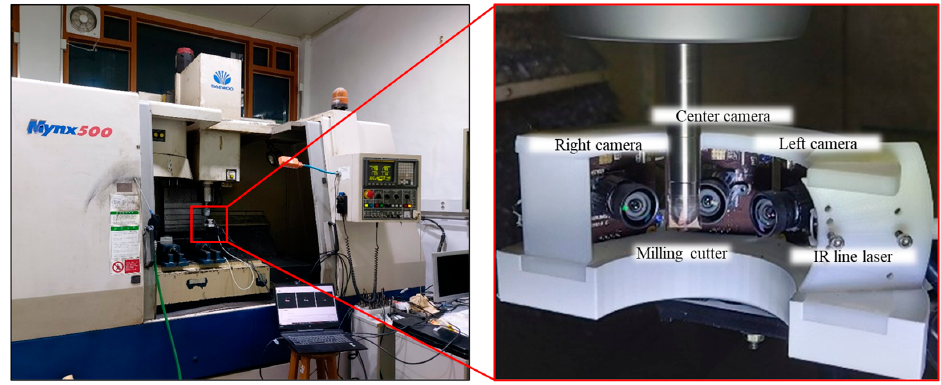
Figure 3. Experimental setup.